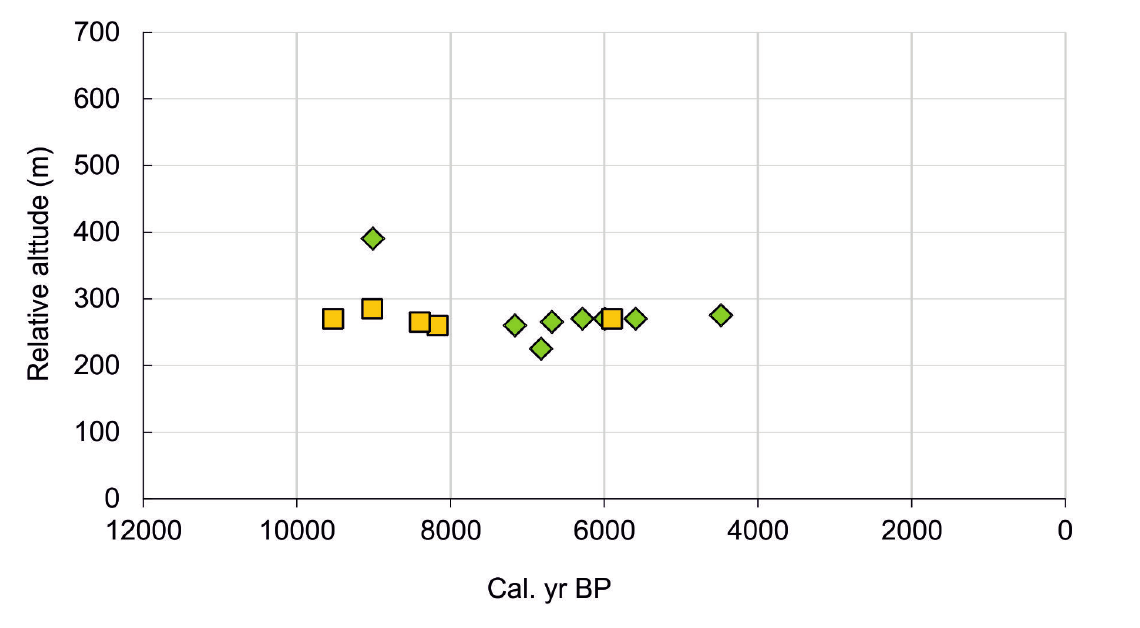
Figure 30: Radiocarbon dates of birch (green) and pine (yellow) megafossils, relative to the present-day position of the birch treeline (zero). Tärna